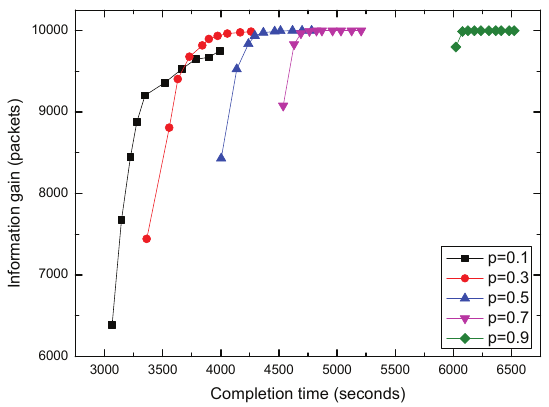
Figure 12. Tradeoff between completion time and information